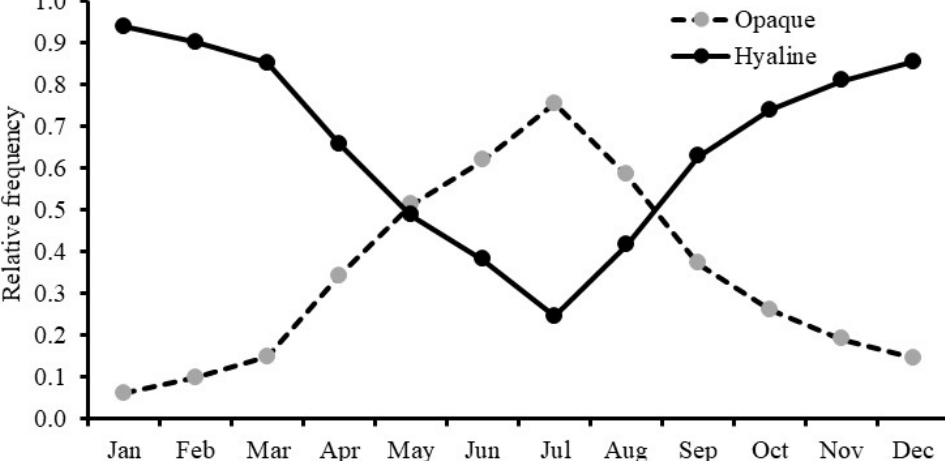
Figure 5. Monthly relative frequencies of otoliths with opaque edge (white circle) and hyaline (black circle) for the temperate Sardinops sagax stock in the southern California Current System (CCS) from 2005 to 2014.